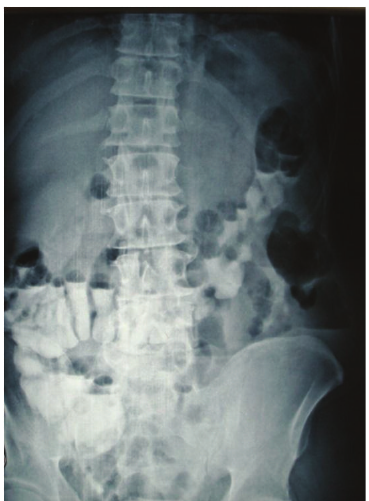
Figure2:AbdominalX-rayshowinginflammationattheleftlumbar